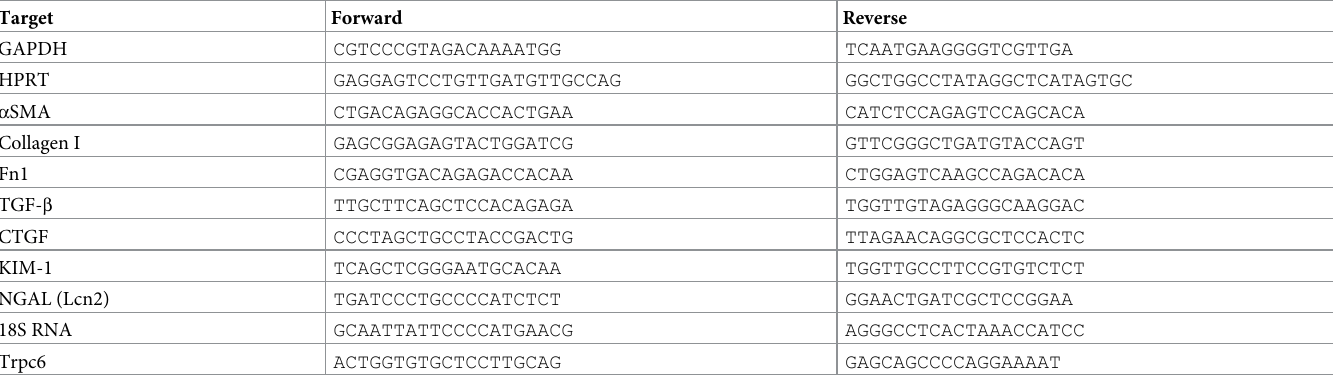
Table 1. Primer sequences used for qPCR gene expression